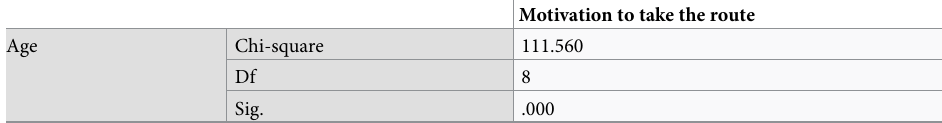
Table 8. Pearson chi-square